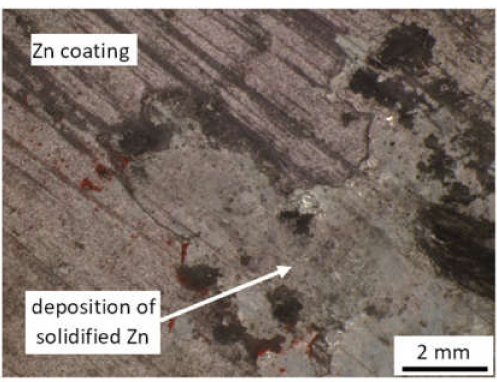
Figure 4. Deposition of solidified Zn melt on the Zn coating—coating thickness 190 ± 28 µ m (linked with Figure 3f).